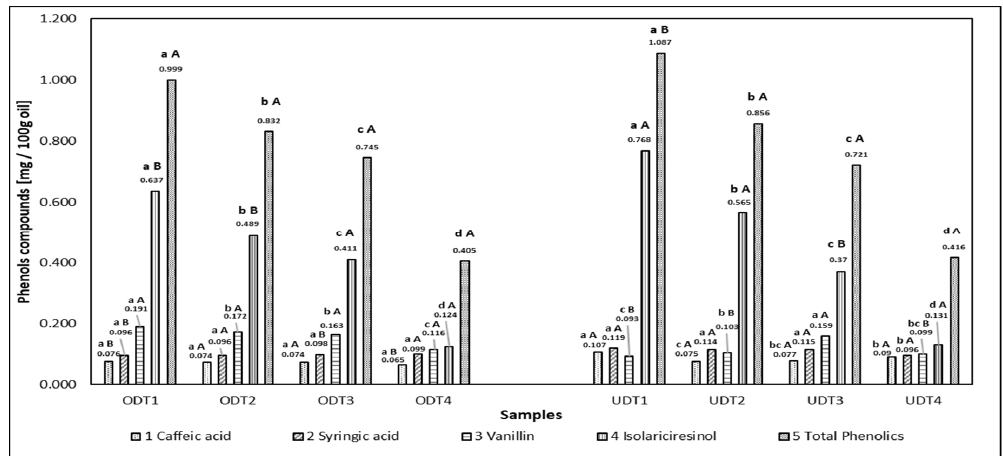
Figure 1. Individual and total phenolic compounds detected by HPLC-MS in cold-pressed pumpkin seed oil (UD) and oleogel (OD) fresh (T1) but also stored for one (T2), five (T3) and eight months (T4) at room temperature. For the same compound, lower-case letters within each sample group (oleogel or oil) indicate no significant difference ( p > 0.05); for the same compound and storage time, upper-case letters between each sample type (oleogel vs. oil) indicate no significant difference ( p > 0.05). For caffeic acid, syringic acid and isolariciresinol lower amounts were detected in the oleogel samples in comparison with the oil. Isolariciresinol is a lignan commonly identified in the pumpkin